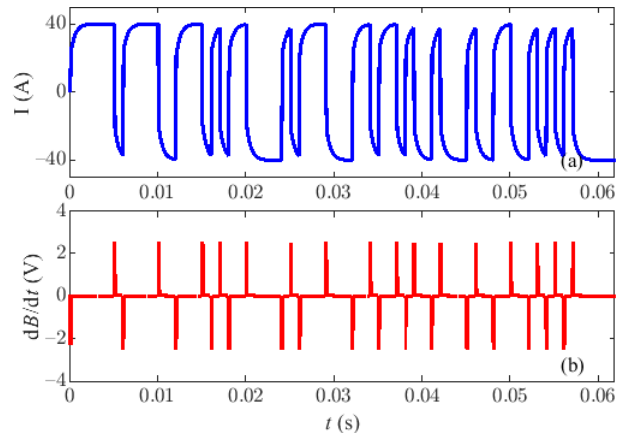
Figure 16. The recorded data. ( a ) The recorded transmitted current signal, ( b ) The recorded induced TEM signal.